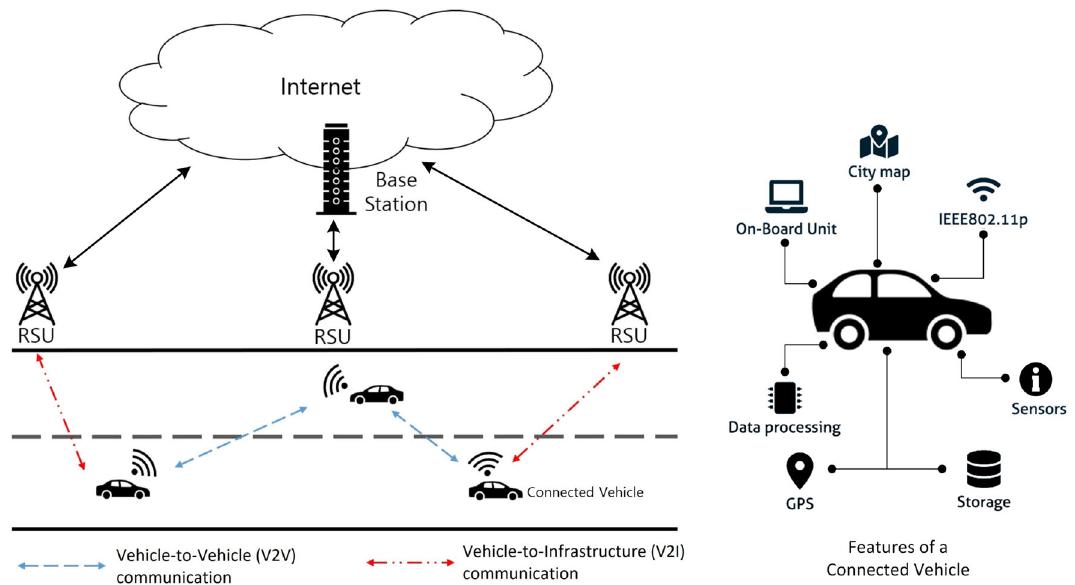
Fig. 1 Connected vehicle